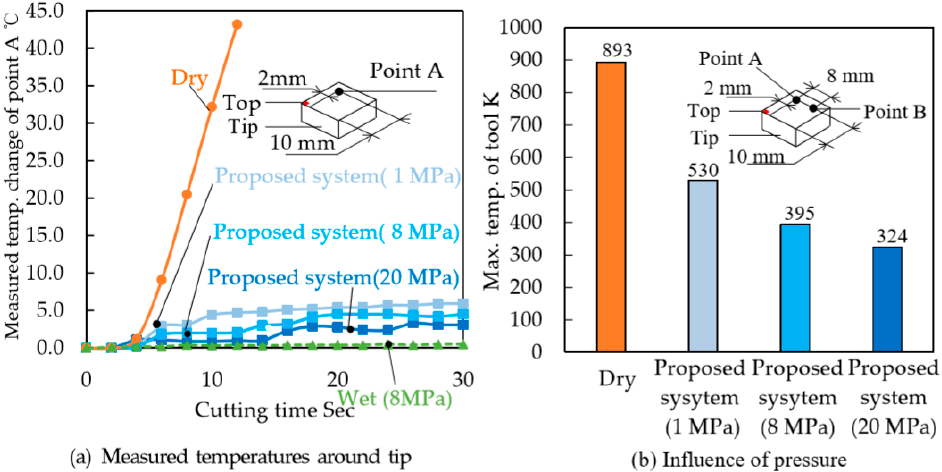
Figure 3. Temperature change on the tool using high-pressure coolant (In the case of Ti6Al4V).